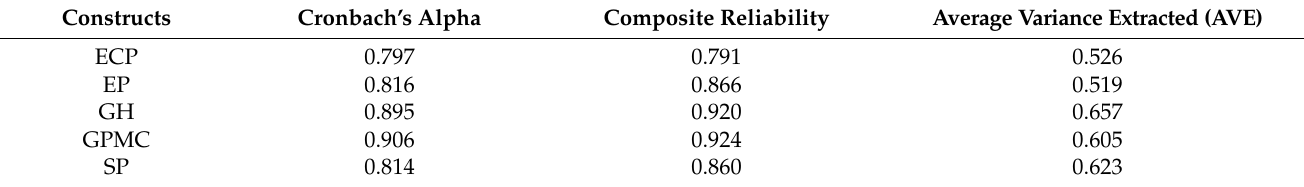
Table 3. Construct reliability and